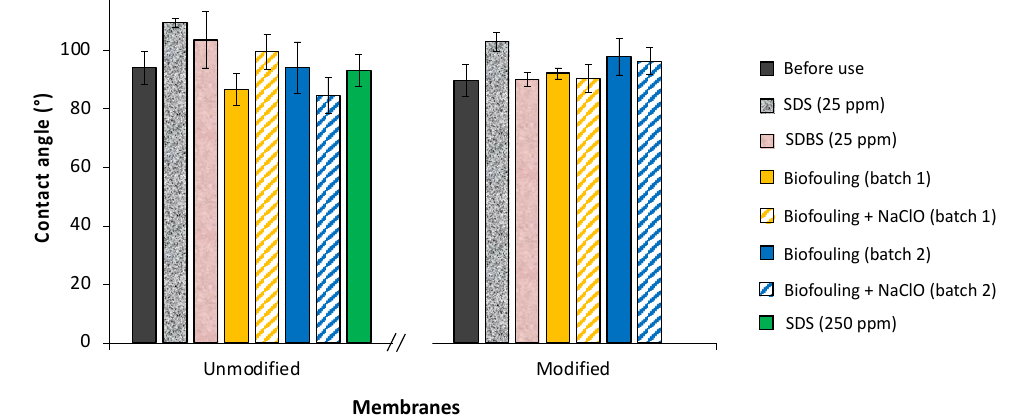
Figure 1. Contact angle results of different (bio)fouled AEMs.